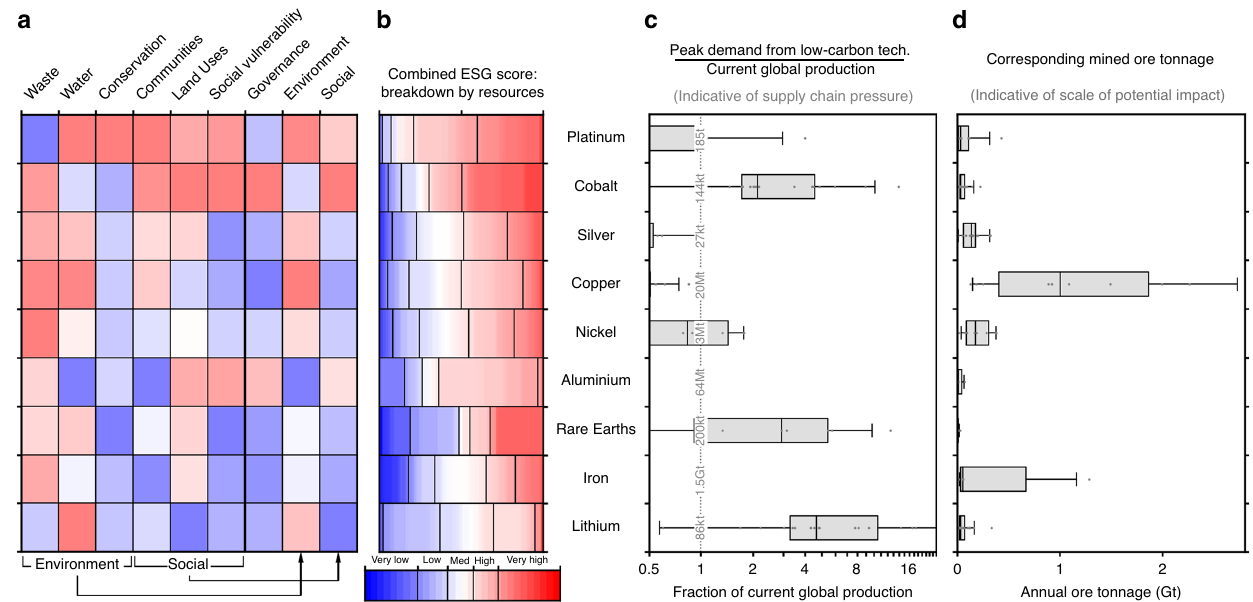
Fig. 1 Risk pro fi les and demand projections for nine energy transition metals. a Environmental, social and governance risk matrix for nine metals ranked by total score, de fi ned as the sum of the scores for the seven dimensions ( fi rst seven columns). b The breakdown of total risk scores by resource tonnage. Colours correspond to risk levels. c The projected demand associated with growth in low-carbon energy technologies for the same nine metals, as a fraction of current global production. Individual data points and boxes that show the mean (vertical bar) and interquartile range of literature estimates ( n = 17), and error bars show the 5th and 95th percentiles. The dashed vertical line indicates current production, with the adopted values for each metal given in small text along this line. d The approximate mined ore tonnage that this demand will translate to. Individual data points and boxes that show the mean (vertical bar) and interquartile range of literature estimates ( n = 17), and error bars show the 5th and 95th